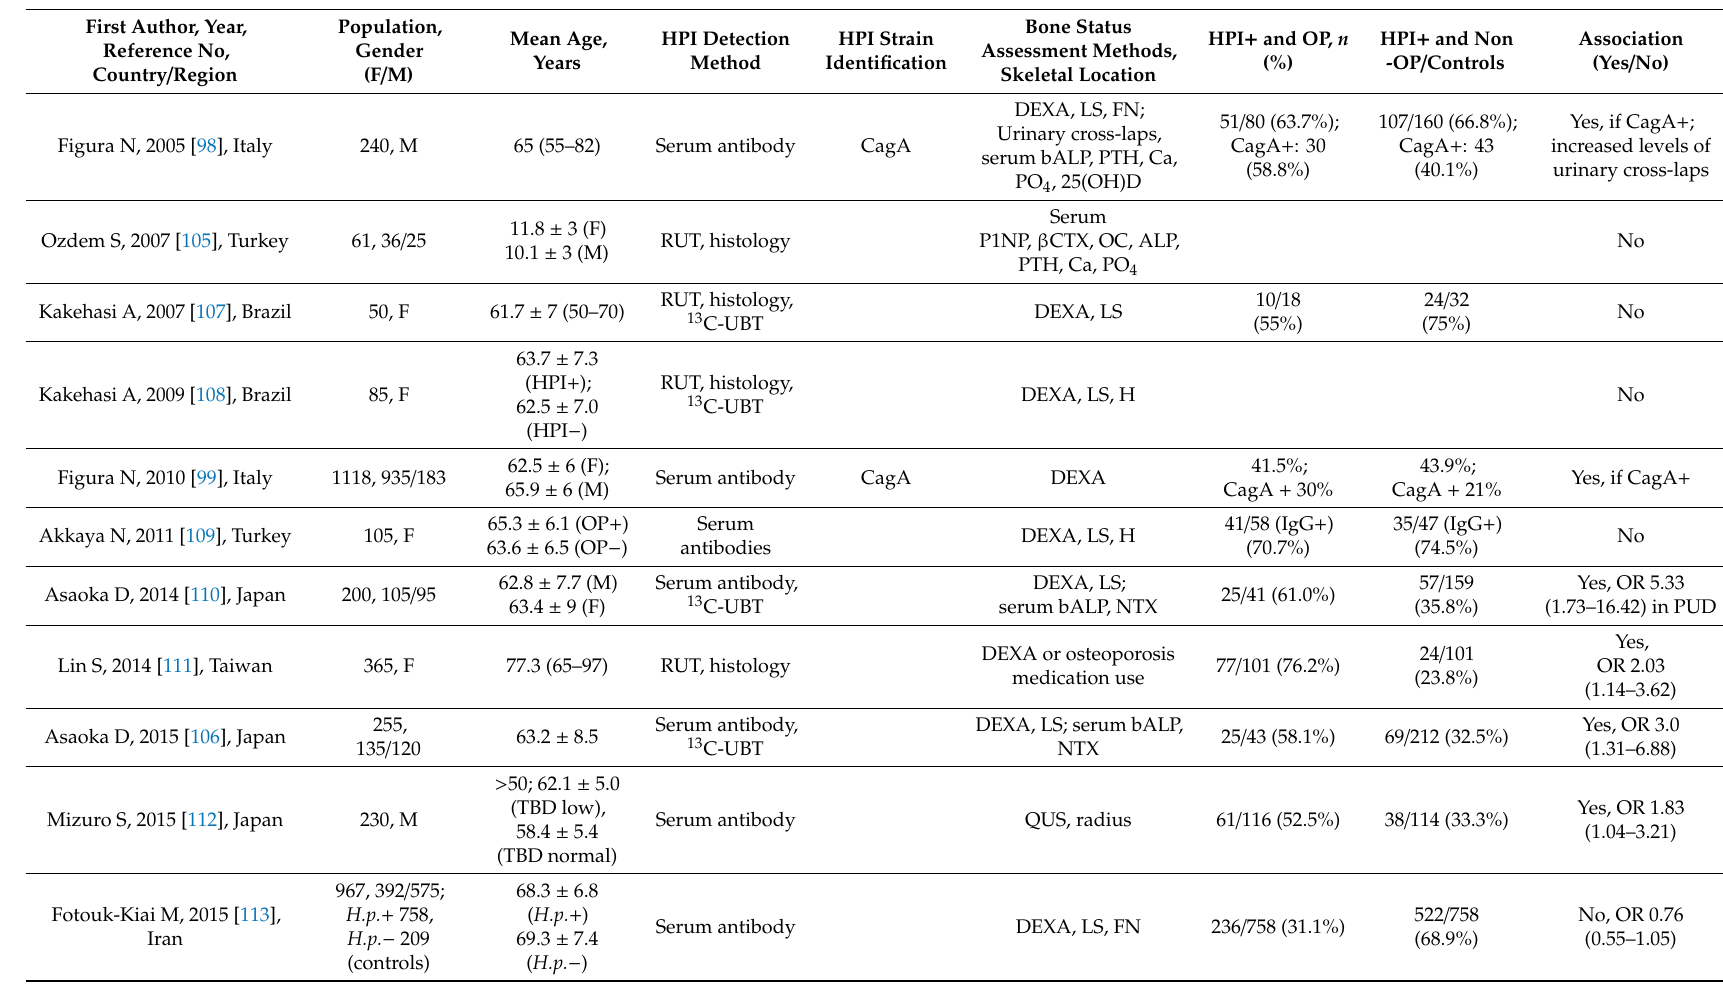
Table 1. Data on relationship between H. pylori infection (HPI) and bone status /